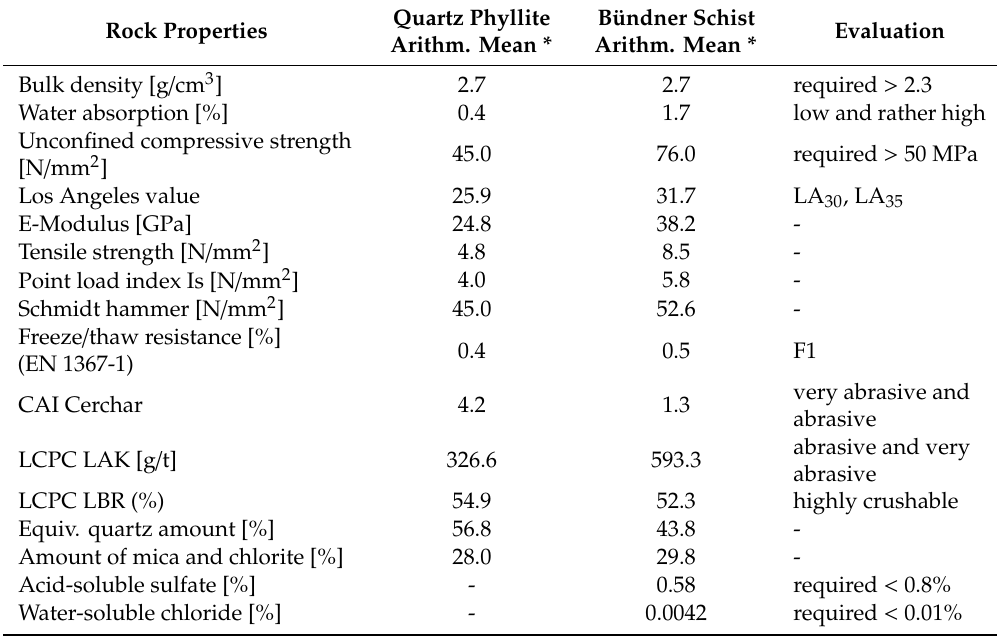
28.0 0.58 required < 0.8% - 0.0042 required <